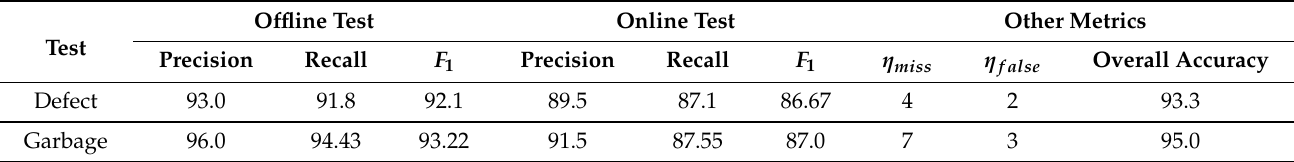
Table 3. Statistical measures for defect and garbage’s